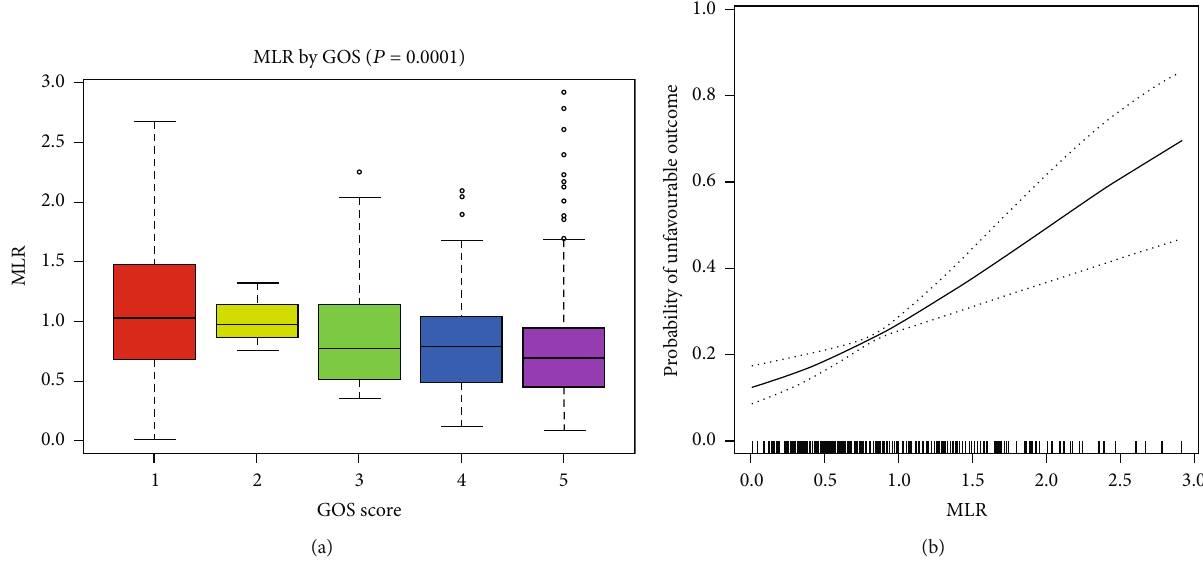
Figure 7: MLR was positively associated with 6-month unfavorable outcome. (a) MLR in each GOS group. (b) Relationship between MLR and the incidence of 6-month unfavorable outcome after cerebral contusion b . b Adjusted for sex, age, coagulopathy, subdural hemorrhage, time to baseline CT time, baseline traumatic intracerebral hematoma volume, and location of